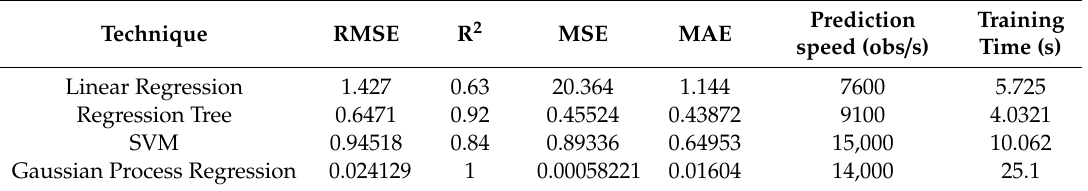
Table 6. Comparison of UV–vis validation results with other